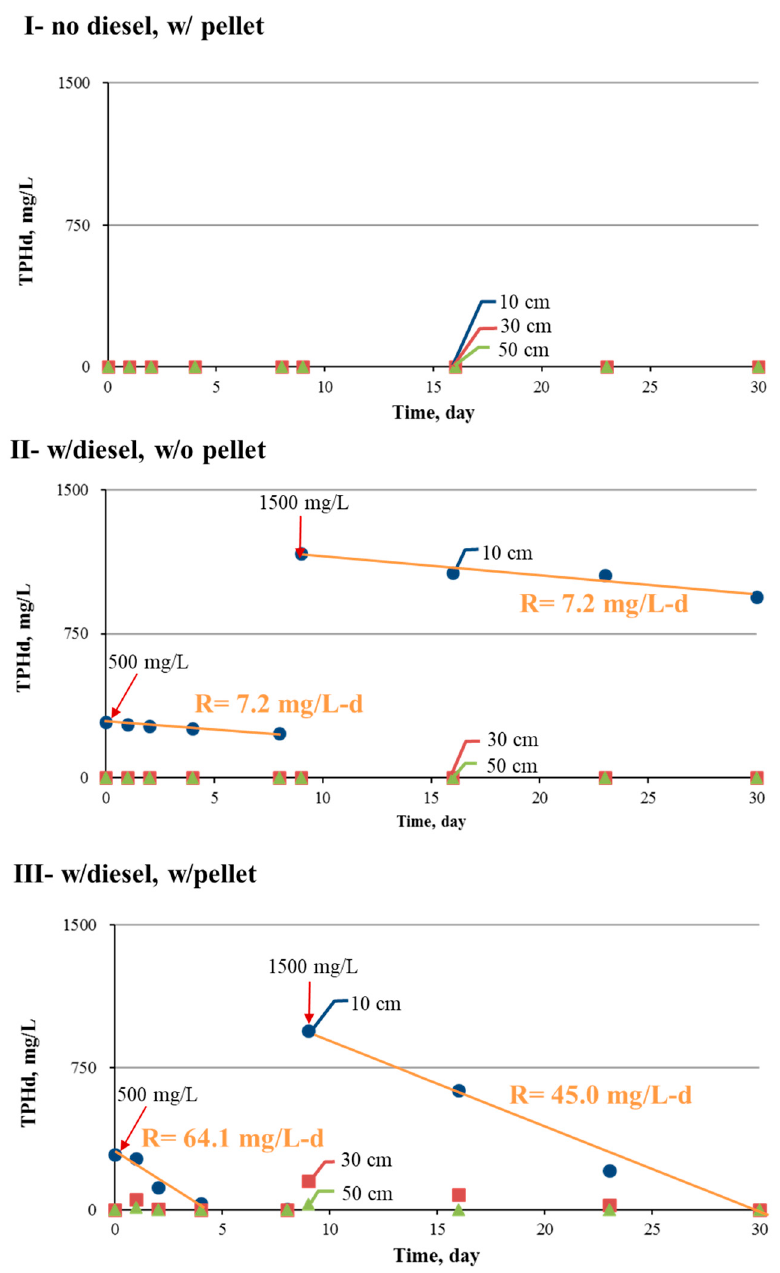
Figure 8. TPHd removal over time in the mimicked groundwater system.